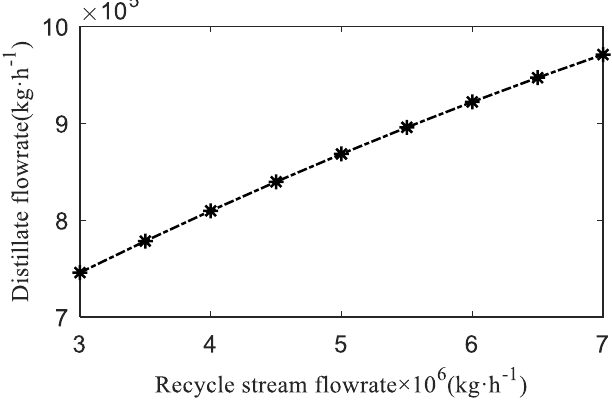
Figure 11. Effect of recycle stream flowrate ( Re W ) on brine temperature (TBT and BBT).